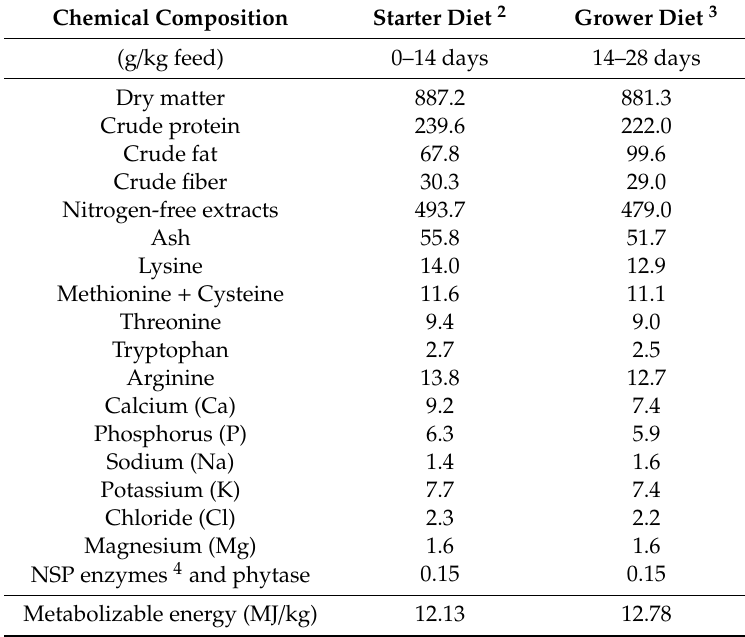
Table 1. Diet composition 1 .